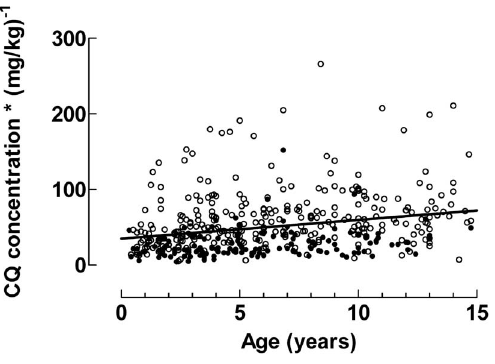
Figure 4. Desethyl chloroquine/chloroquine ratio as a function of chloroquine concentration. The DCQ/CQ ratio decreased with increasing CQ concentrations (p , 0.001), Data from patients treated with 25 mg/kg of CQ are given by closed circles ( patients treated with 50 mg/kg of CQ are given by closed circles ( open circles ( #